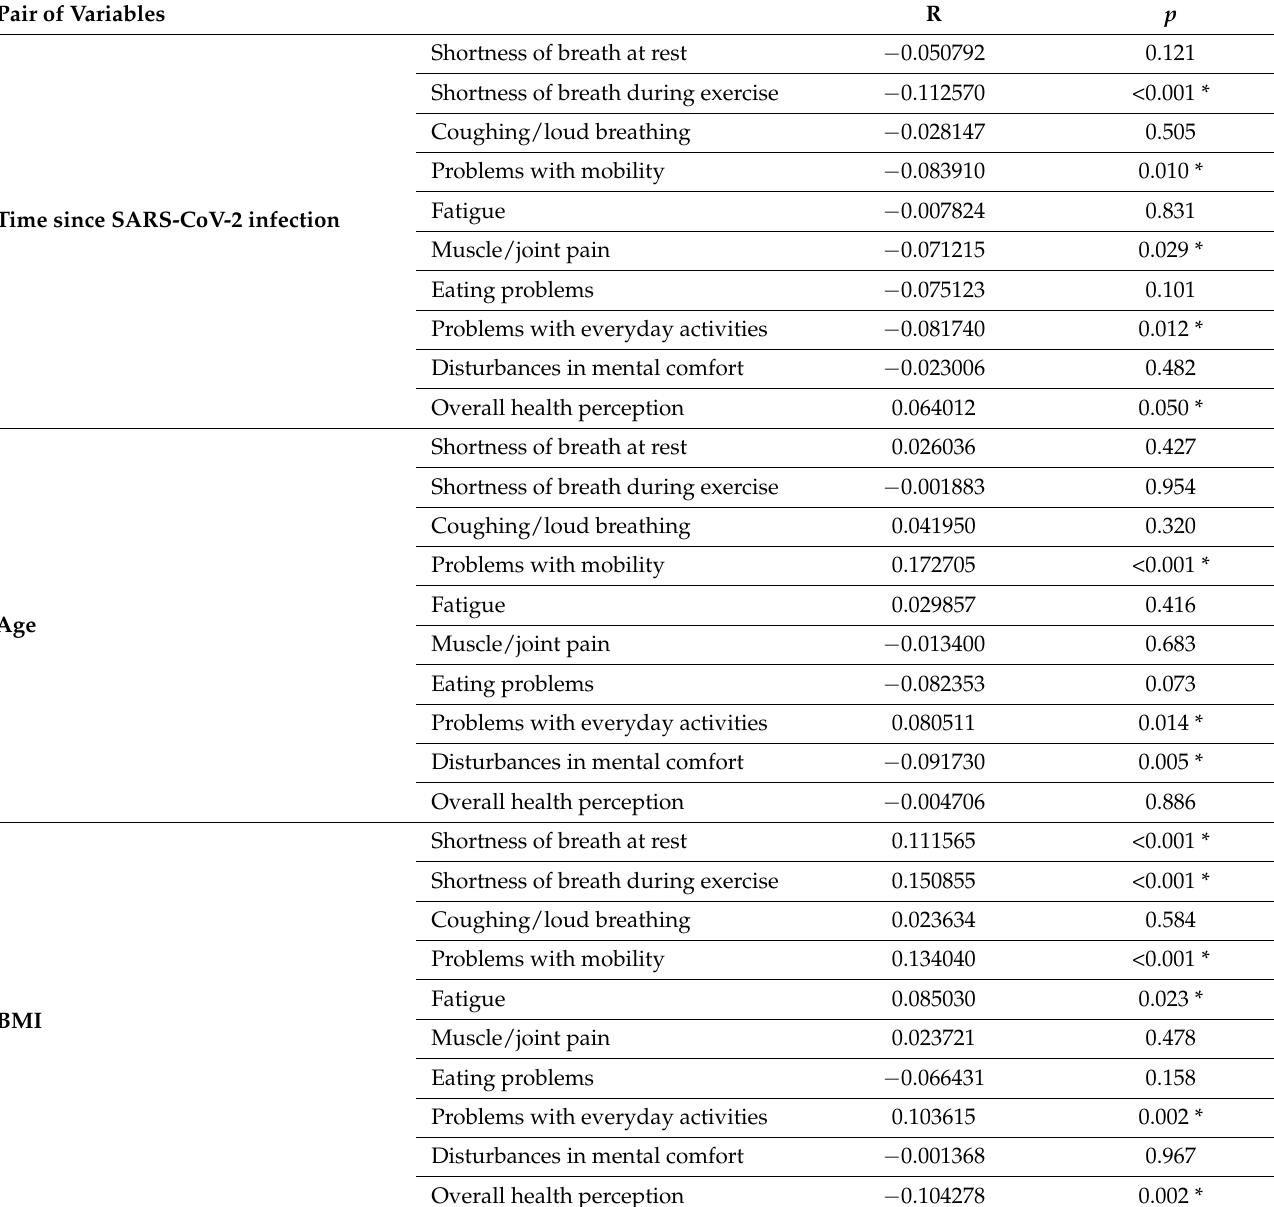
Table 2. Correlation between the time since infection, age and nutritional status, and complications after